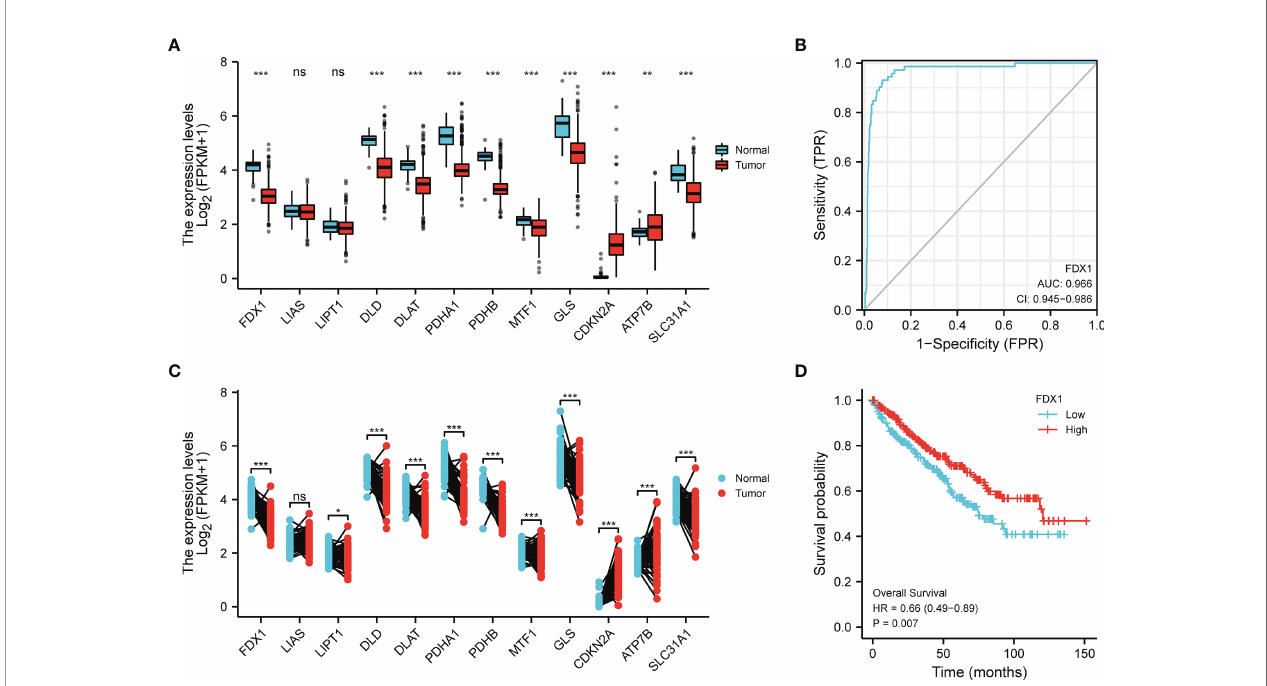
FIGURE 1 | Transcriptional alterations and diagnostic/prognostic value of CRGs in KIRC. (A) Expression of 12 CRGs in tumors and normal tissues. (B) Expression of 12 CRGs in tumors and juxta-tumoral tissues. (C) ROC analysis of FDX1 as a diagnostic marker. (D) KM curves of OS. *p < 0.05, **p < 0.01, ***p < 0.001, ns, p >